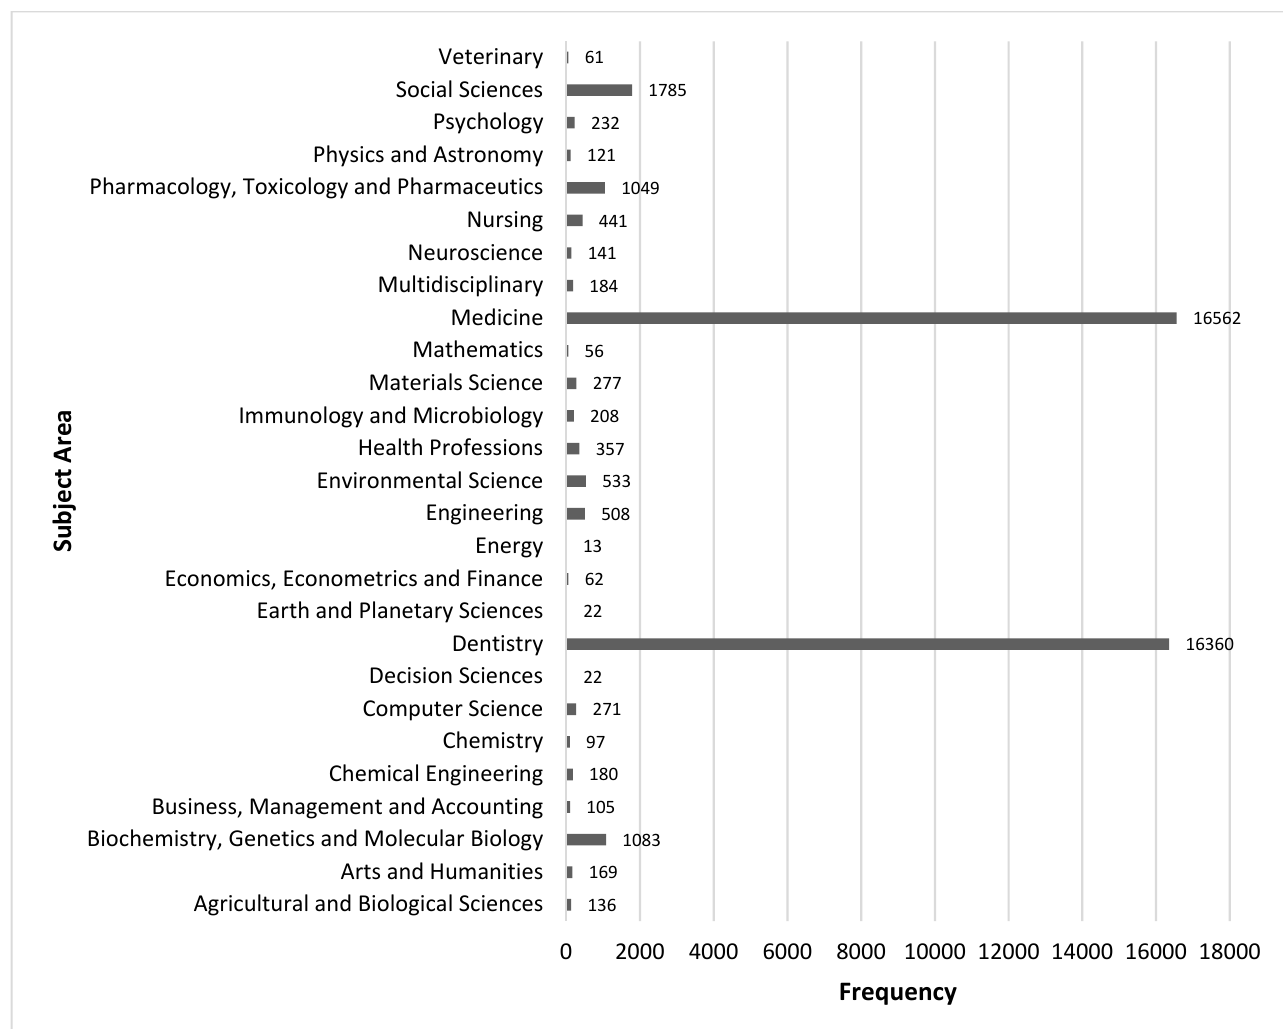
Figure 5. Distribution of articles by subject area. A total of 159 countries/territories sourced the articles on dentists, with the top ten countries being the United States (TA = 5690), the UK (TA = 2831), India (TA = 2607), Brazil (TA = 2188), Germany (TA = 1283), Japan (TA = 1044), Italy (TA = 960), Saudi Arabia (TA = 927), Australia (TA = 925), and Turkey (TA = 773) (Figure 6). The top ten institutions sourcing these articles are depicted in Table 5. Half of these institutions are situated in the Global South. The three most productive institutions are in the Global South: Saveetha Dental College and Hospitals (TA = 609 (2.0%); TC = 2532; h-index = 26); Saveetha Institute of Medical and Technical Sciences (TA = 525 (1.7%); TC = 1428; h-index = 17); and Universidade de Sao Paulo (TA = 453 (1.5%); TC = 5390; h-index = 35). Among the top five institutions in the Global North, three were in the